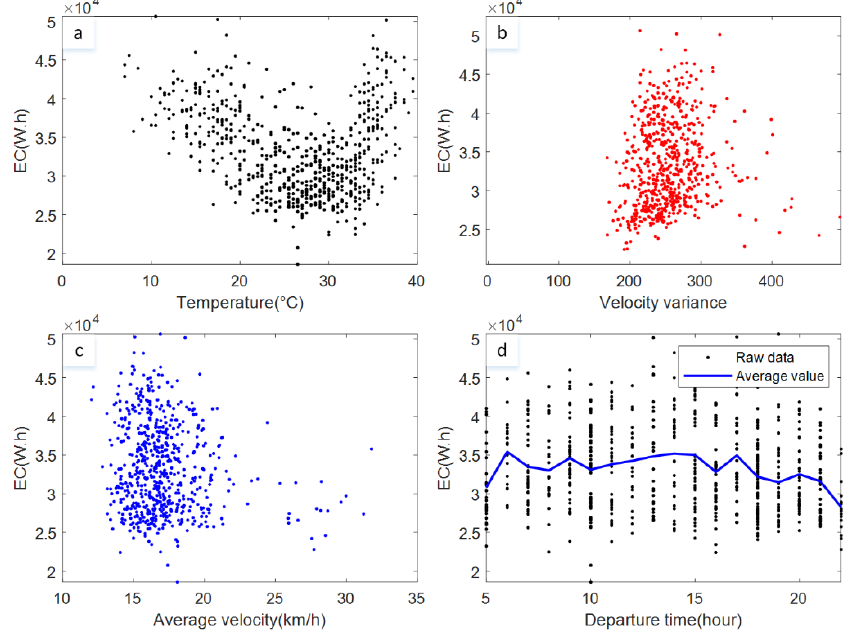
Figure 2. Statistical results of vehicle energy consumption after reconstruction. The relationships of ( a ) temperature, ( b ) vehicle velocity variance, ( c ) average velocity and ( d ) departure time with vehicle energy consumption.